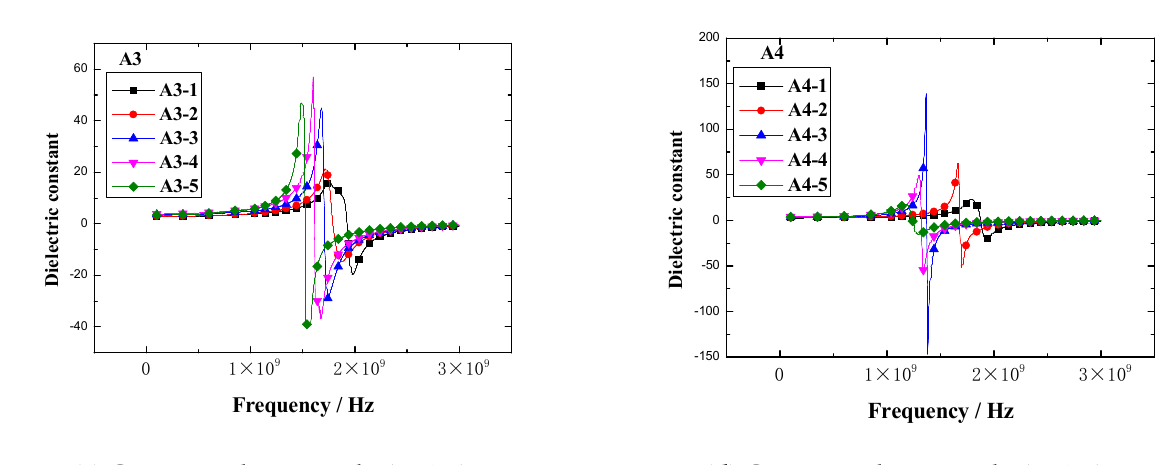
( d ) Corresponding to code A4-1~A4-5 Figure 11. The loss factor vs. frequency plots of the rubber samples. The results demonstrated that the loss factor of the rubber sample also changed with the frequency. The loss factor of each rubber sample also had a peak. The peak of the loss